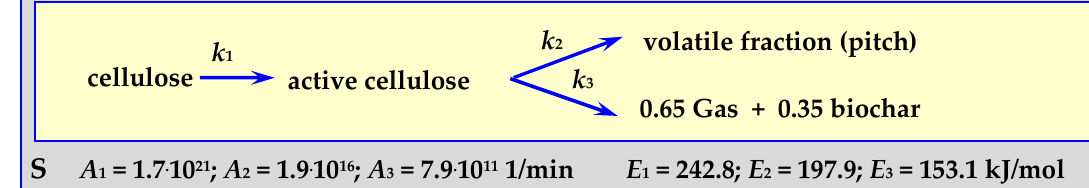
Figure 8. Shafizadeh mechanism for cellulose pyrolysis.